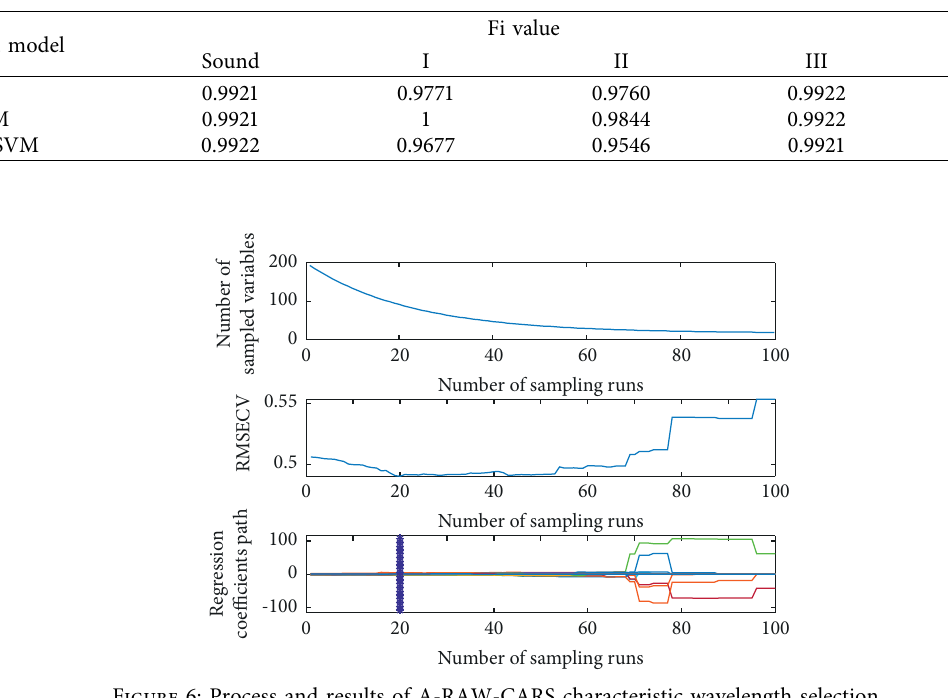
Table 3: Results of macro- F for SVM models based on R-GF, A-RAW, and K-M-COW spectra.